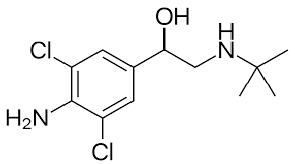
Figure 7. Chemical structure of clenbuterol. Formula: C 12 H 18 C l2 N 2 O. Physiological effect: Selective beta-2 adrenergic receptor agonist used in the treat- ment of asthma [15]. It has potent anabolic and lipolytic effects on muscles and is used by athletes to improve exercise performance.